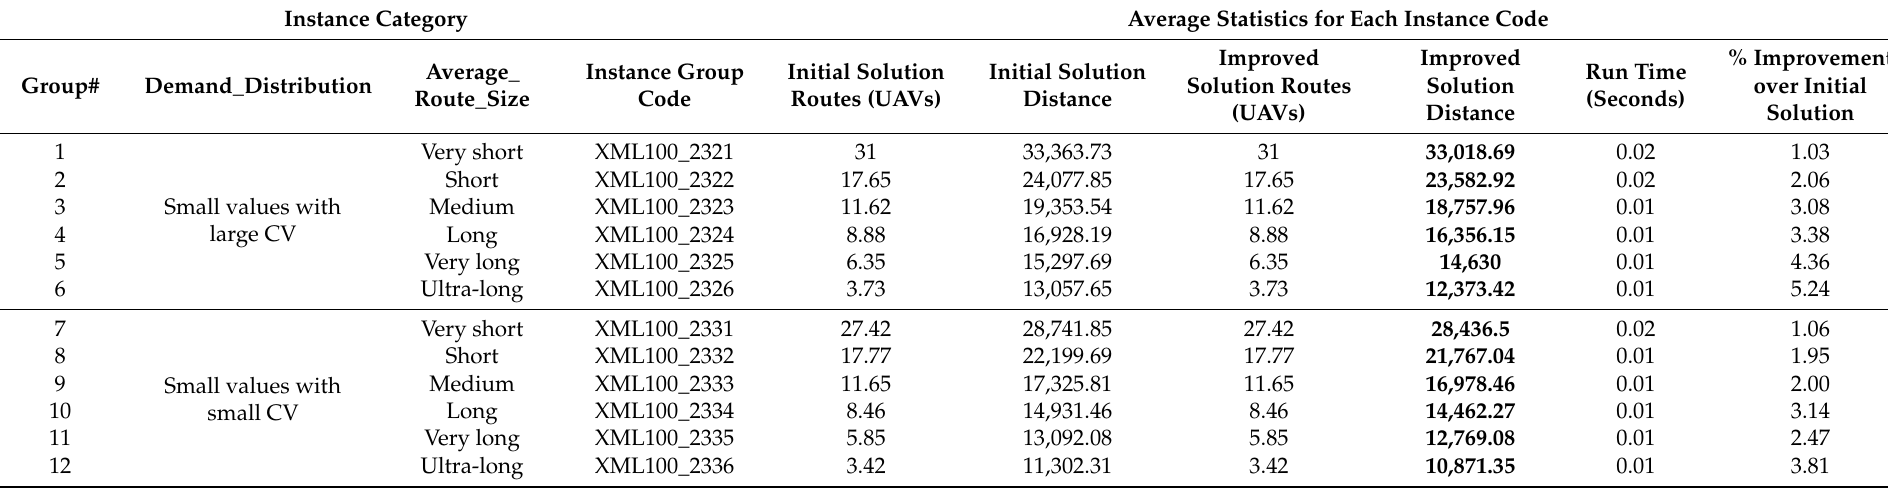
Table A3. Results of the GBCDH on the XML100 dataset with centered depots and random-clustered customer positioning. The bold font indicates values that offer improvements from the initial solution distance to the final solution